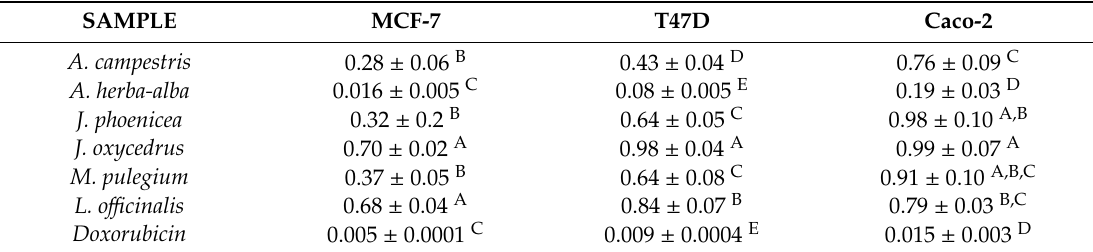
Table 5. Cytotoxic activities of the EOs of the six selected Algerian plants against two human breast adenocarcinoma (MCF-7 and T-47D) and one human colon cancer (Caco-2) cell lines. Results are expressed as LD 50 (mg / mL) ±